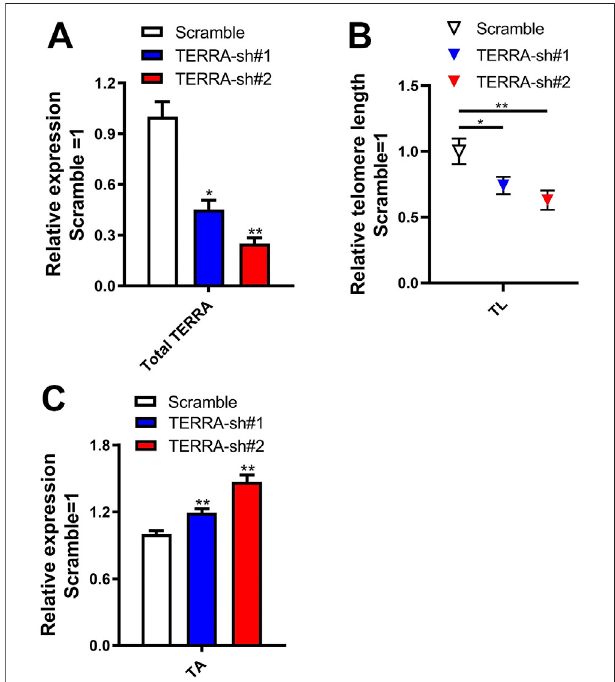
FIGURE 4 | Knockdown of TERRA shortens telomere length and enhancestelomeraseactivityinmESCs. (A) qRT-PCRanalysisoftotalTERRA expression levels using the method published for measuring the relative telomericrepeat DNAcontent.Transcriptlevelswerenormalizedagainst ScrambleshRNAcontrol. * p < .05,** p < .01vs. Scramblecontrol. (B) Relative telomere length (TL) of TERRA knockdown mESCs was measured by